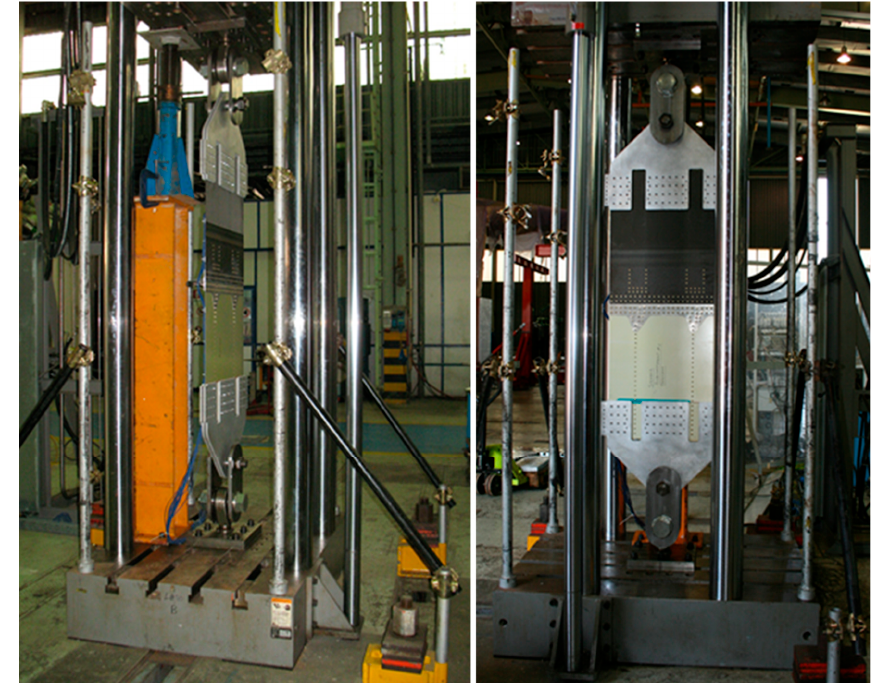
Figure 7. Test rig.